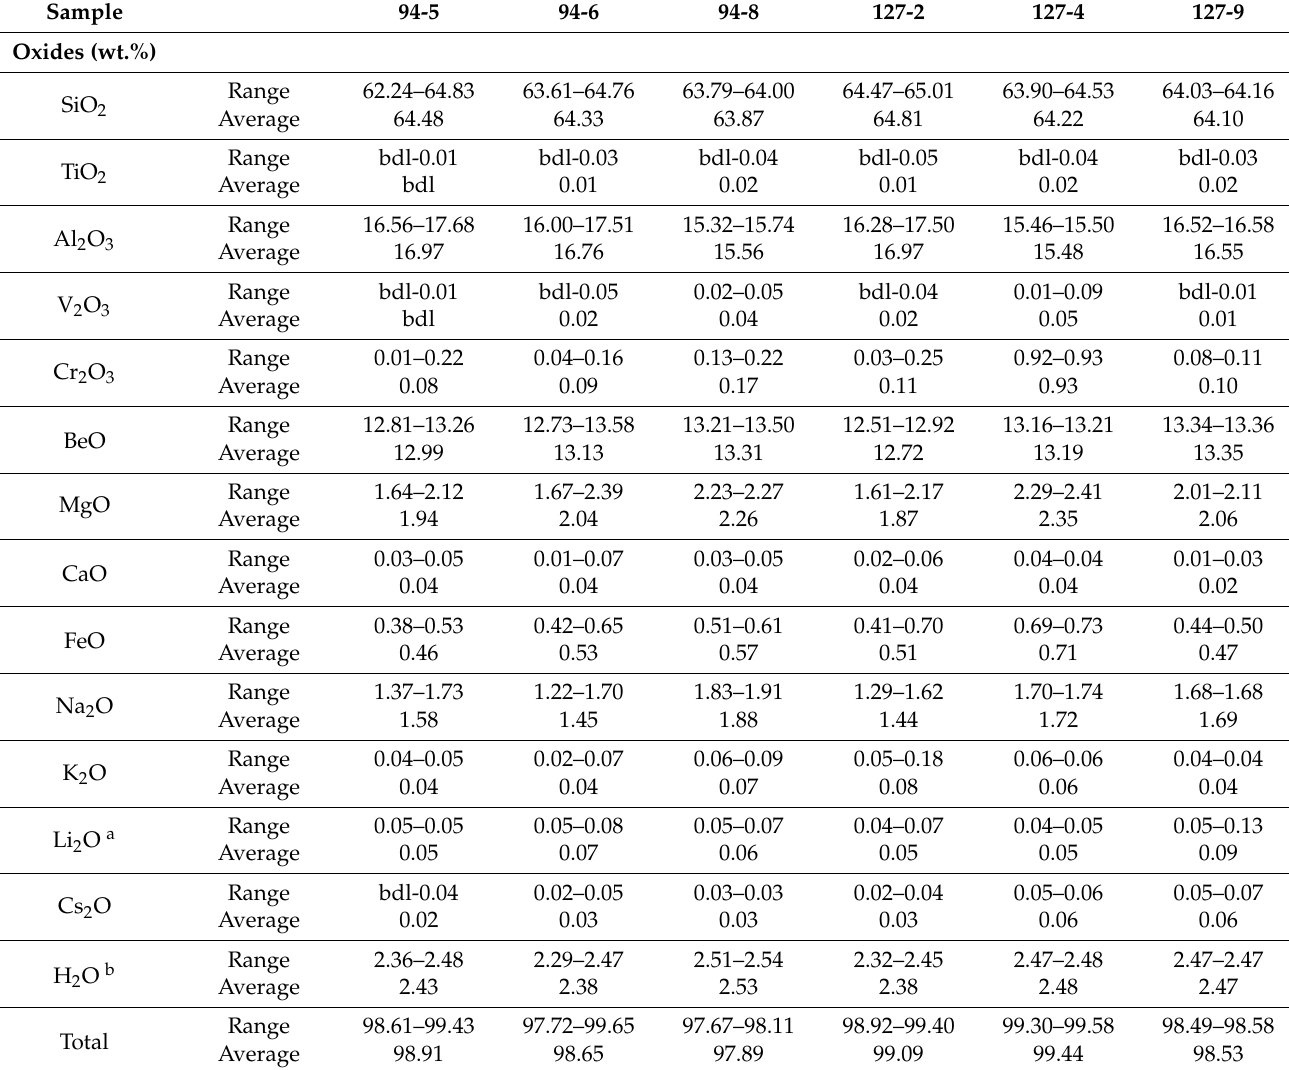
Table 2. Chemical compositions (average) with the structural formulas of emeralds from India occurrence analyzed by